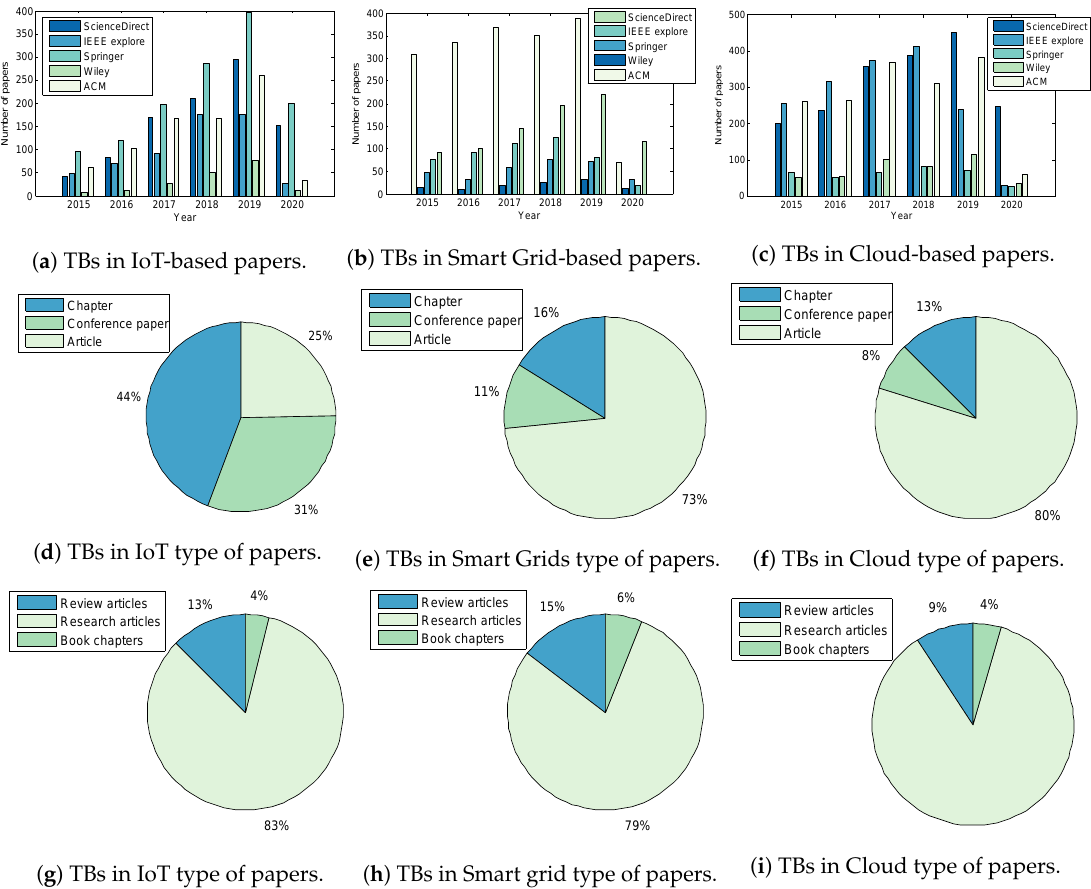
Figure 1. Types of publications in TBs between 2015 and 2020 in Springer and ScienceDirect database